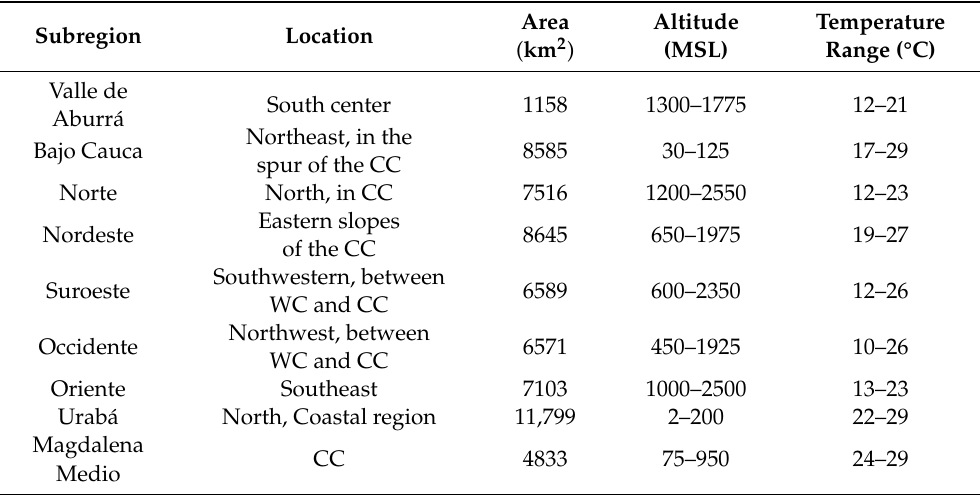
Table 1. Summary of geographical and climatic characteristics for the nine subregions in Antioquia. For further information about description of each subregion, see [17,18].